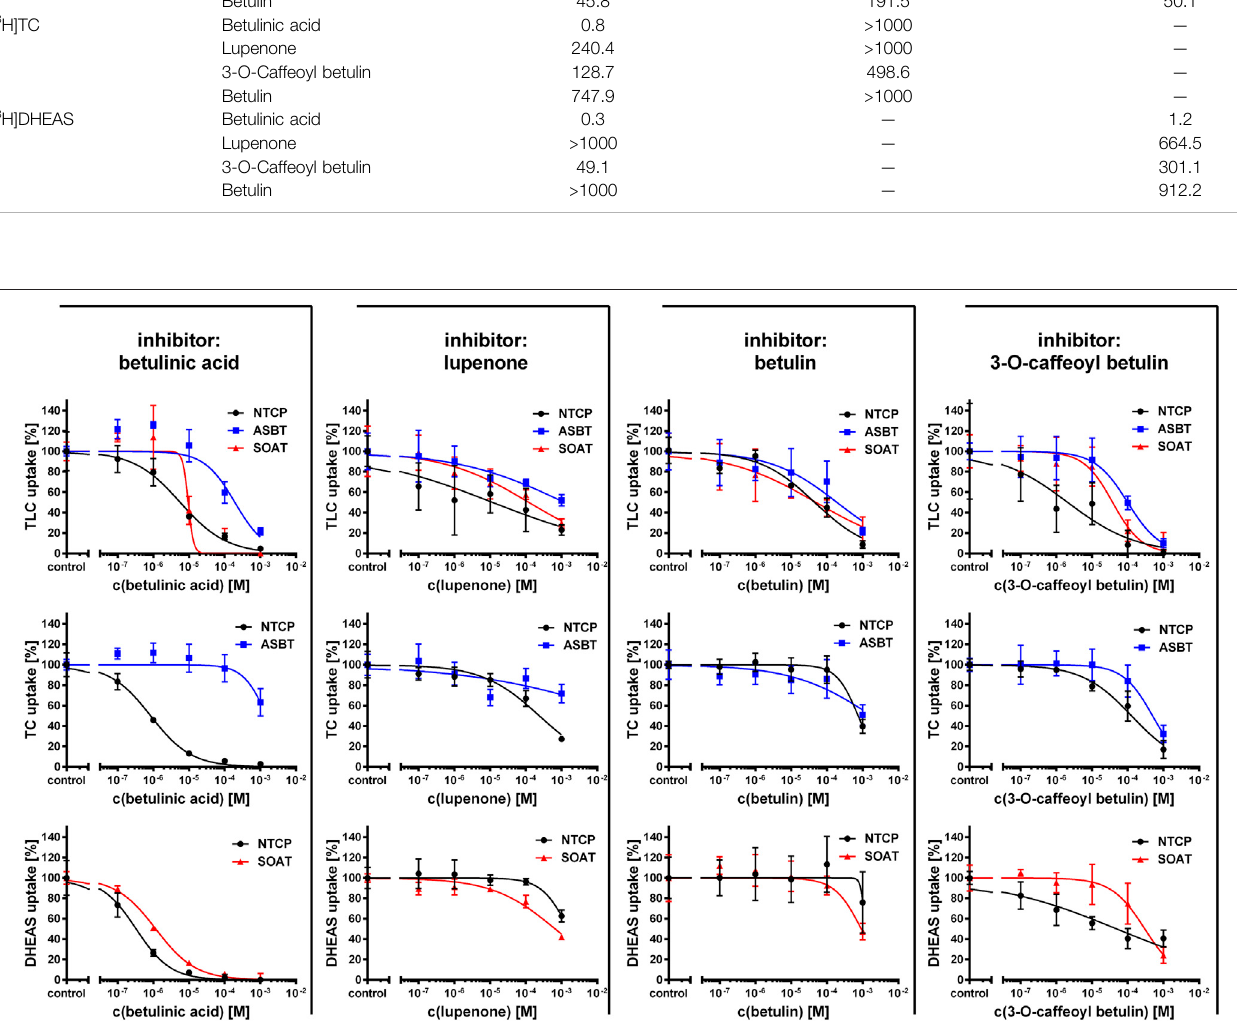
FIGURE 4 | Inhibition of NTCP, ASBT, and SOAT with non-substrate betulin-based inhibitors. Transport of [ 3 H]TC, [ 3 H]TLC, and [ 3 H]DHEAS was analyzed in NTCP-HEK293, ASBT-HEK293, and SOAT-HEK293 cells in the presence of different supposed non-substrate triterpenoid inhibitors as indicated at increasing concentrationsrangingfrom100 nMtill1000 µM.After5 minofpreincubationwiththerespectiveinhibitorycompound,1 µM[ 3 H]TLC,[ 3 H]TCor[ 3 H]DHEASwereadded foradditional10 minat37 ° Candthecelllysateswereanalyzedbyliquidscintillationcounting.Experimentsperformedwithoutinhibitorweresetto100%.Meansof negative controls were subtracted to calculate net transport rates (expressed as percentage of control). Data represent means ± SD of quadruplicate determinations of representative experiments. IC 50 values were calculated by sigmoidal dose-response (variable slope) with a goodness of fi t ≥ 0.95 (GraphPad Prism software, version 6.05). IC 50 values are listed in Table 4